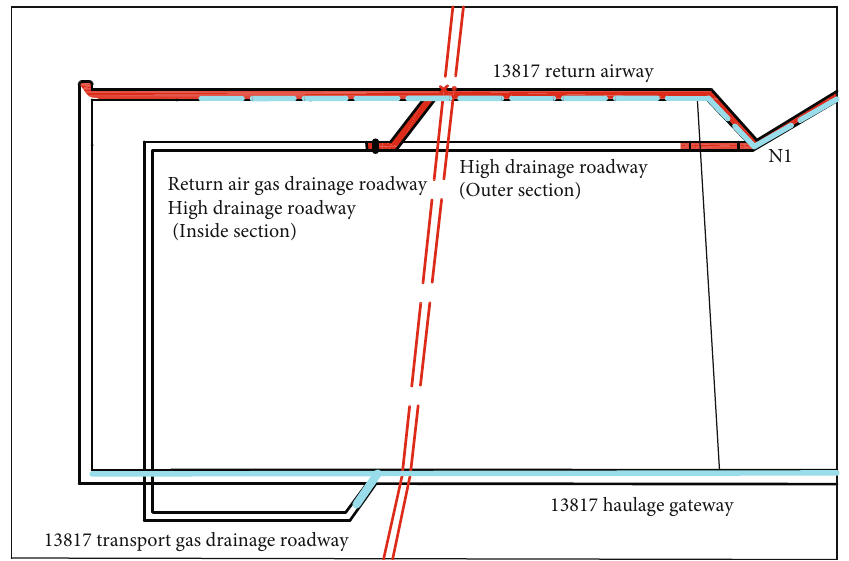
Figure 22: 13817 high drainage roadway layout plane